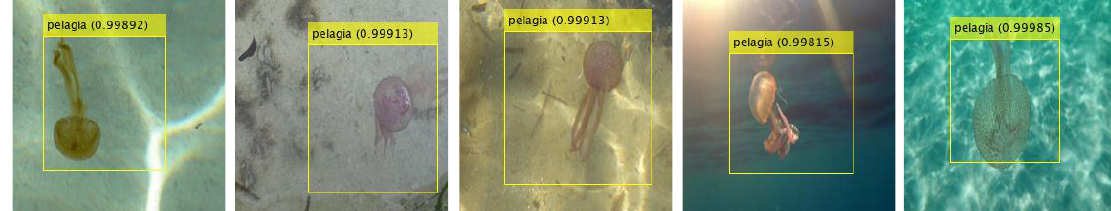
Figure 5. Output by classification model 5 for Cotylorhiza tuberculate (friedegg jellyfish).